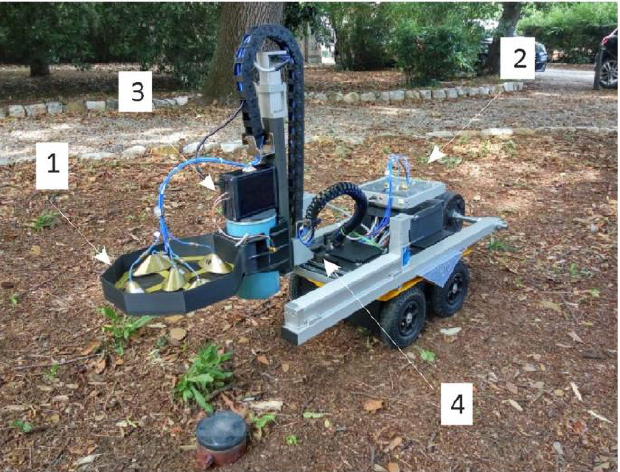
Figure 20. Robotic platform “Ugo 1st” [89 ]: (1) ISR antenna array, (2) ISR controller, (3) HSR, (4) 3D camera, and (4) antenna array.